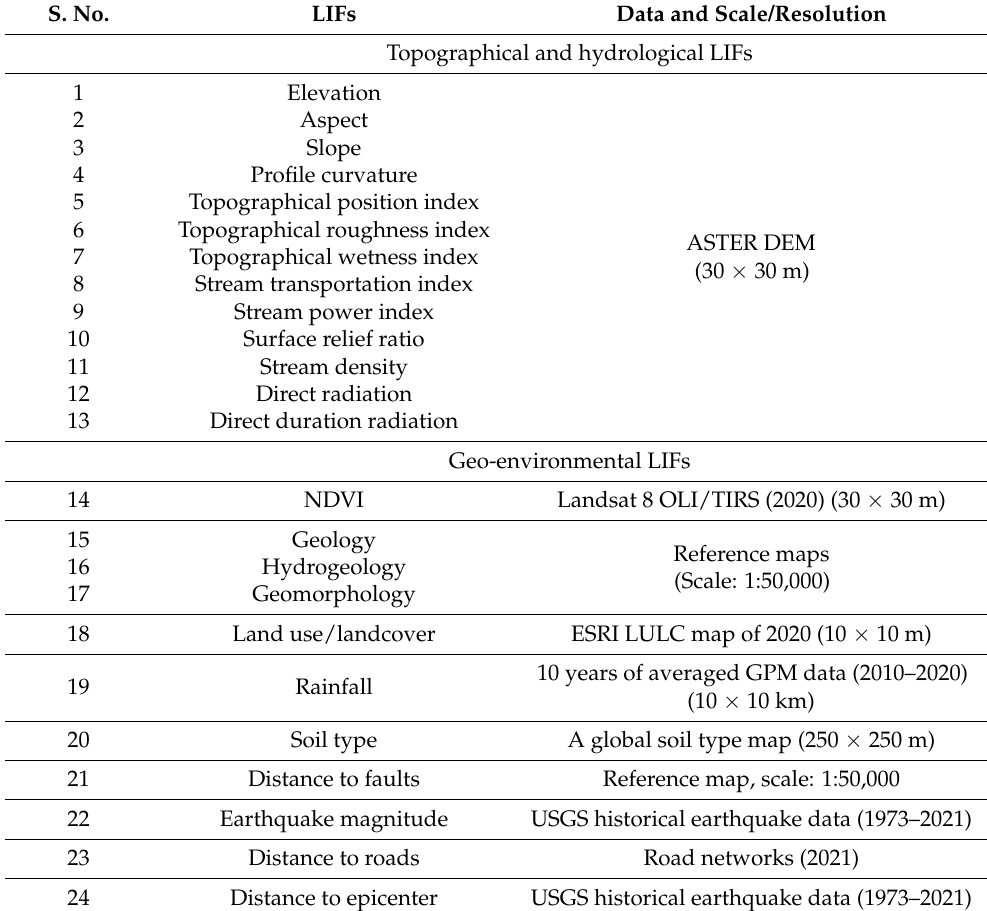
Table 1. Remotely sensed and auxiliary datasets were used to prepare different LIFs. S. No. LIFs Data and Scale/Resolution Topographical and hydrological